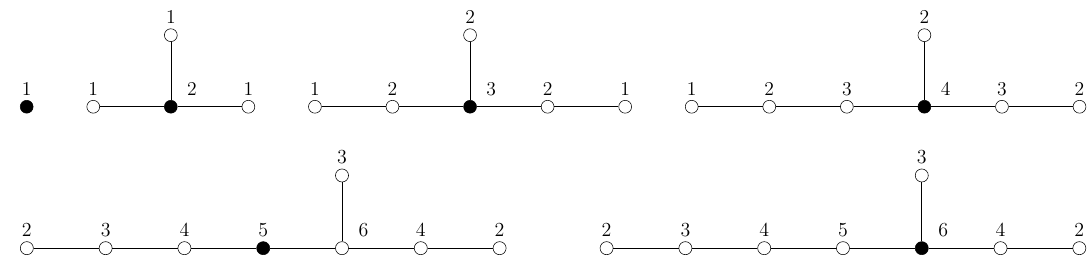
Figure 7 . The ‘colored’ Dynkin diagrams A 1 ; D 4 ; E 6 ; E 7 ; E 8 corresponding to the chosen subgroup of the full Weyl group. (We consider two di(cid:11)erent colorings for E 8 .) We will be quotienting the Cartan torus by the Weyl group of the white sub-diagram T